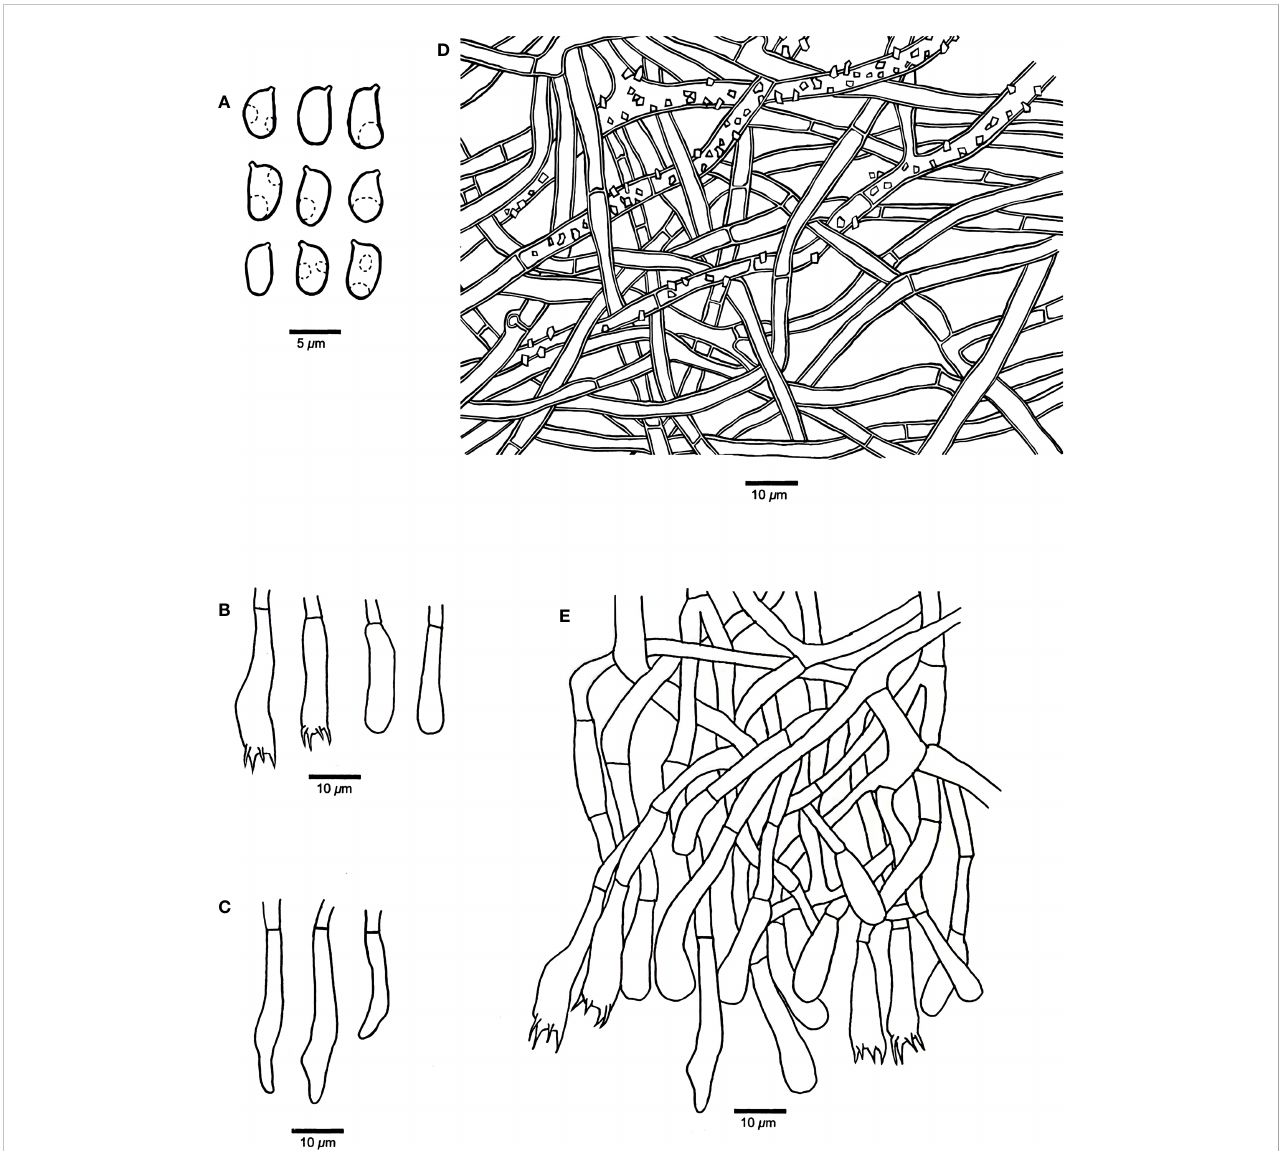
FIGURE 2 Microscopic structures of Phanerochaete shenghuaii (drawn from the holotype, Dai 24610). (A) Basidiospores. (B) Basidia and basidioles. (C) Cystidia. (D) A vertical section of the subiculum. (E) A vertical section of the